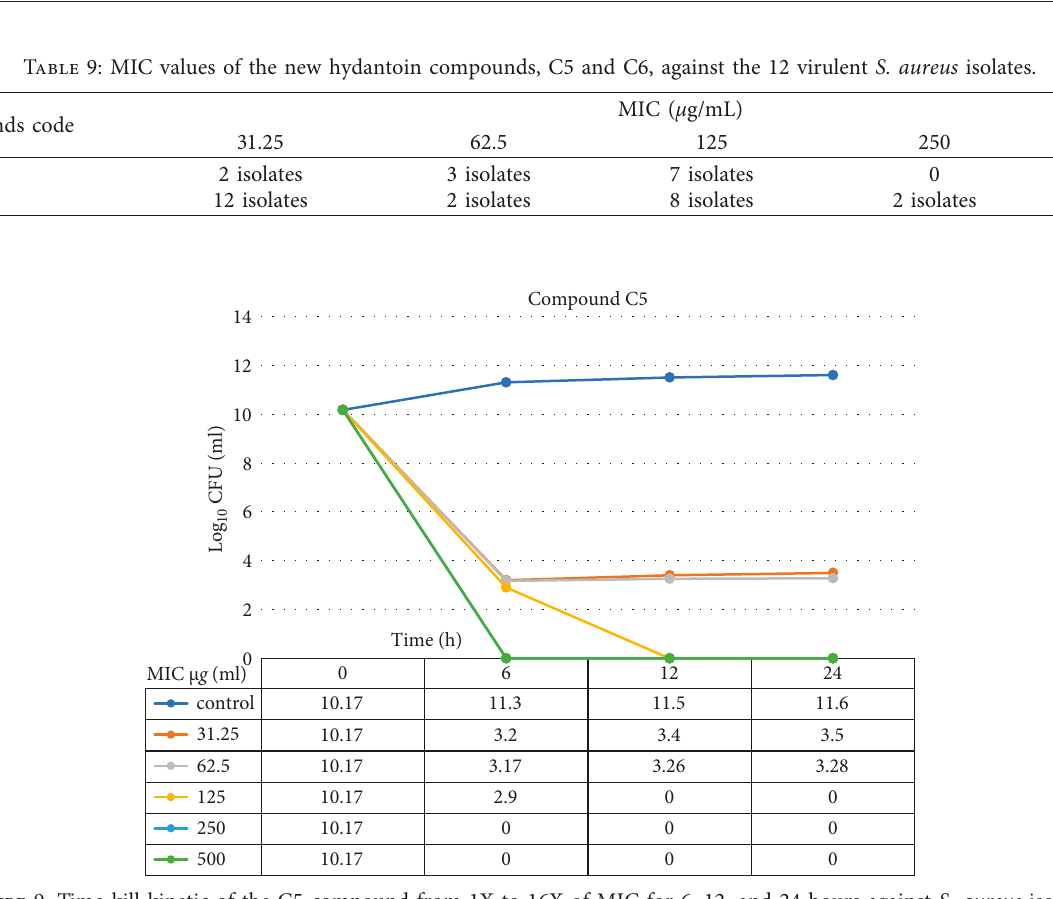
Figure 9: Time-kill kinetic of the C5 compound from 1X to 16X of MIC for 6, 12, and 24 hours against S. aureus